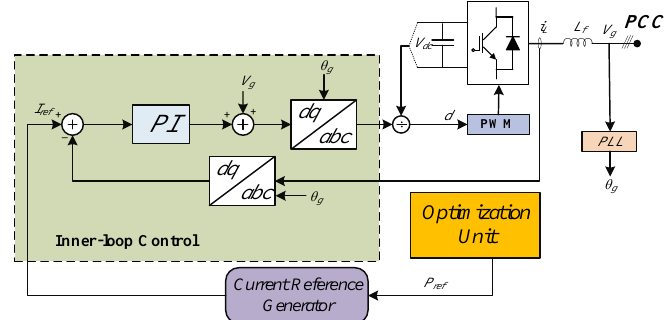
Figure 3. Local controllers structure in current control